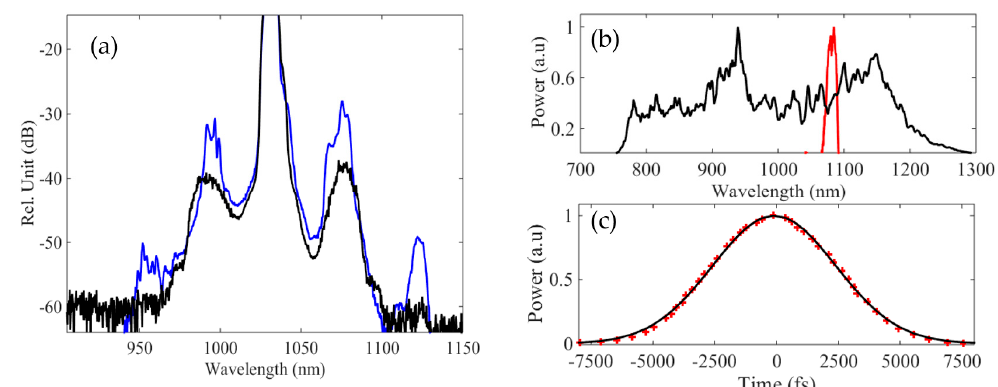
Figure 4. ( a ) Fluorescence spectrum when the PCF is pumped by 31 mW (black line). Output spectrum when the signal is injected at null delay (blue line). ( b ) Spectrum of the continuum generated in the ANDI fiber (black line) and spectrum of the signal (red line). ( c ) Autocorrelation trace (red stars) and the Gaussian fit (solid black line) of the signal.